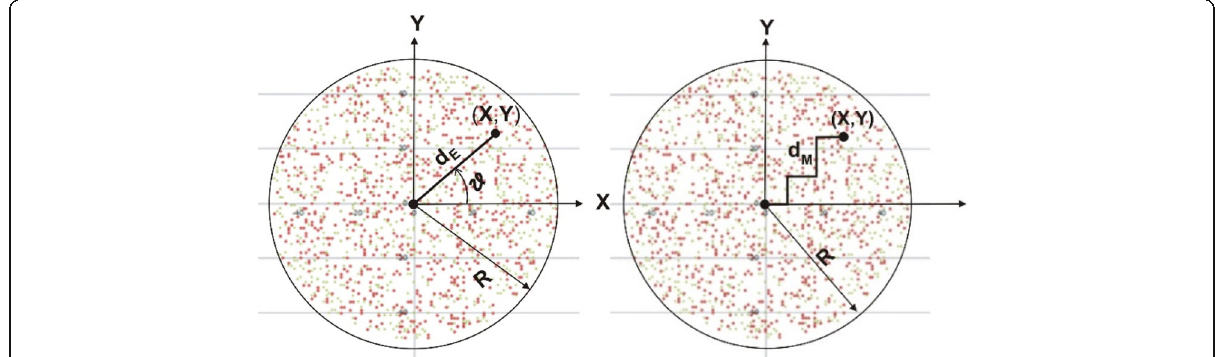
Fig. 1 Euclidean (left) and Manhattan (right) drayage